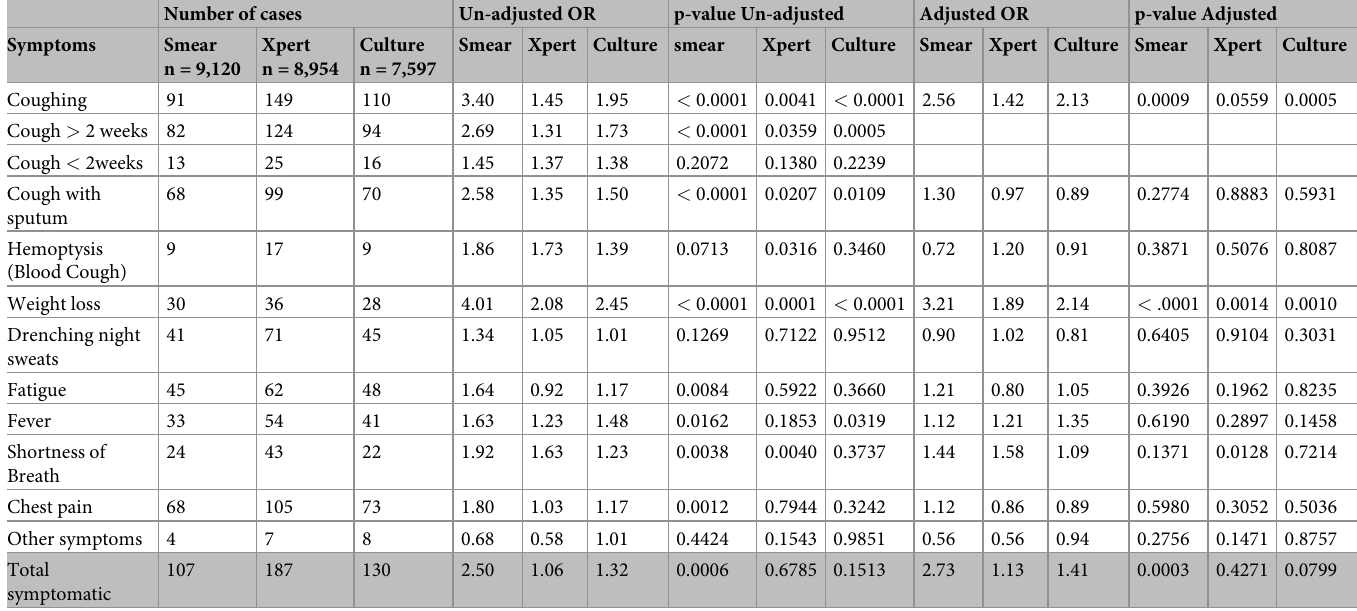
Table 9. Association between the method of TB diagnosis and presence of TB related symptoms. Number of cases